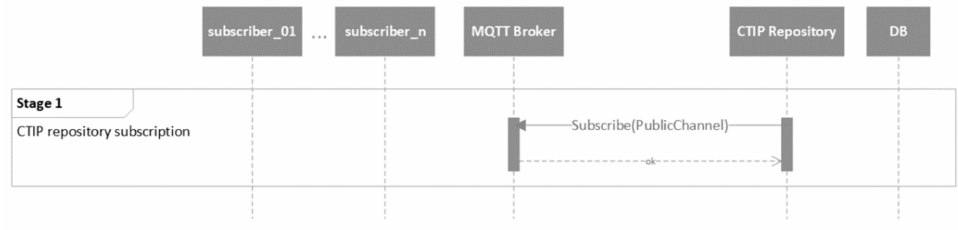
Figure 10. UML behavioral diagram of the CTIP repository subscription stage (stage 1).